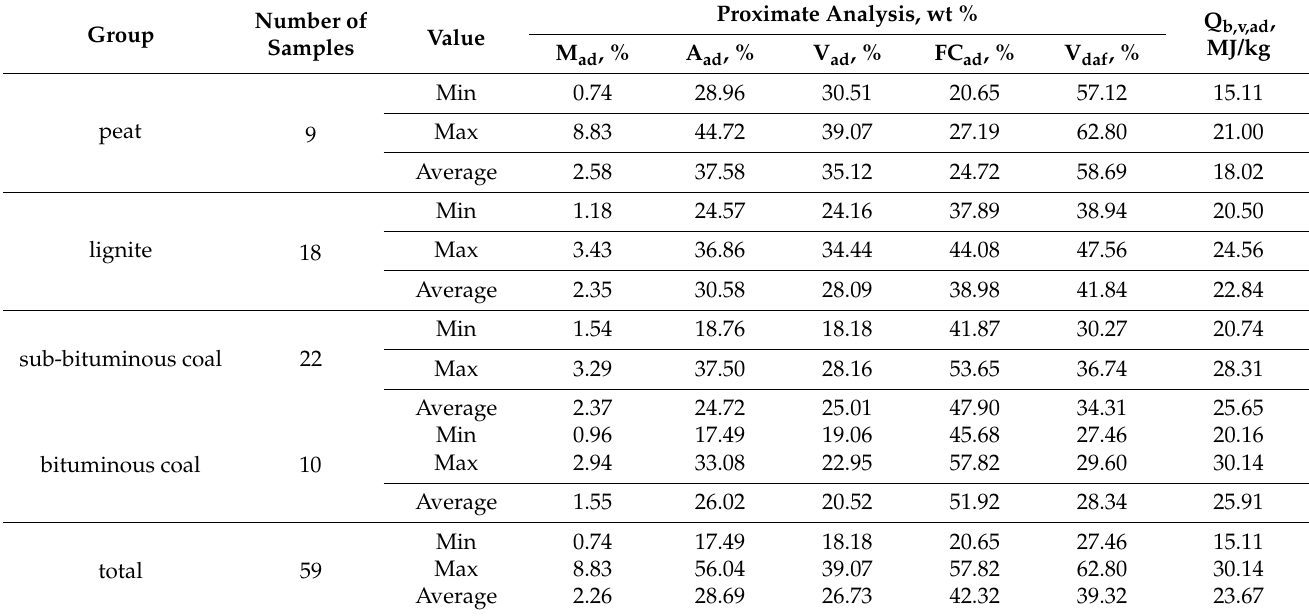
Table 2. Proximate analysis of the coal samples.